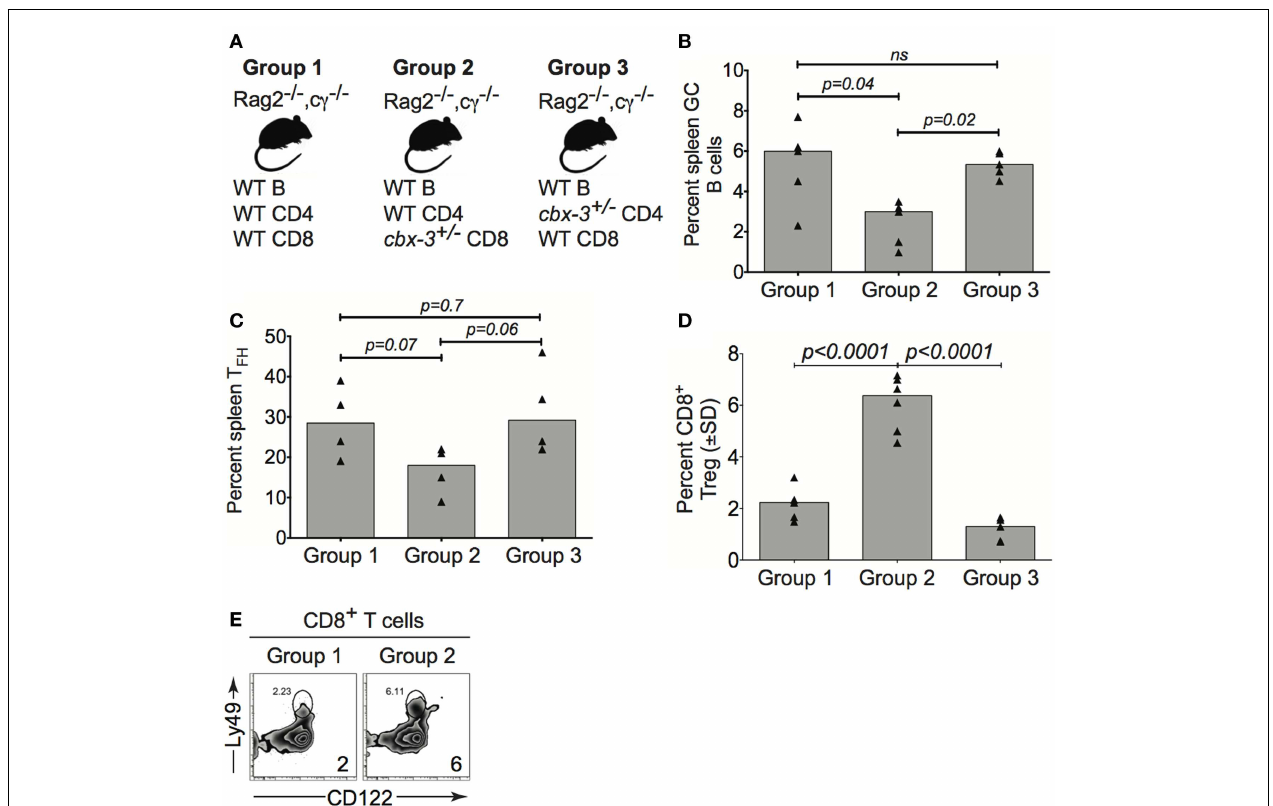
cbx-3 + / − mice. (B,C) On day 10 after NP-CGG in alum immunization, spleens of recipients were analyzed by FACS to determine the frequency of GC (from the B220 + gate) andT FH (from theTCR β + CD4 + gate) populations. (D,E) The frequency of CD122 + Ly49 + CD8 + T reg cells (from the CD3 + gate) was determined by FACS (E) and plotted (D) . Numbers on bottom right corners indicate percent cells. Statistical analysis was performed with GraphPad one-way ANOVA; ns, not